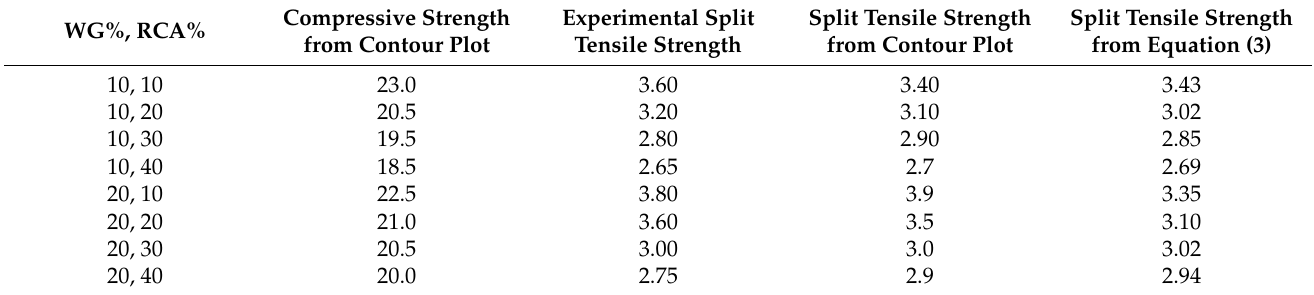
Table 5. Experimental and predicted split tensile strength.